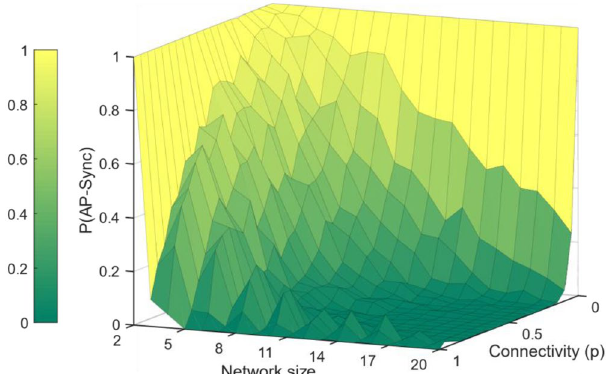
Figure 3. Effect of connectivity with network size on anti-phase synchronization. Probability of anti- phase synchronization reduces with network size and with degree of connectivity in random graphs. When connectivity is low, AP synchronization is stable for larger sizes. Differences in stability between odd and even sizes are evident. Fully connected even-sized networks are easier to synchronize as partitioning in to two groups is easier than fully connected odd-sized networks odd-sized networks. The odd-even effect reduces with decreasing connectivity.